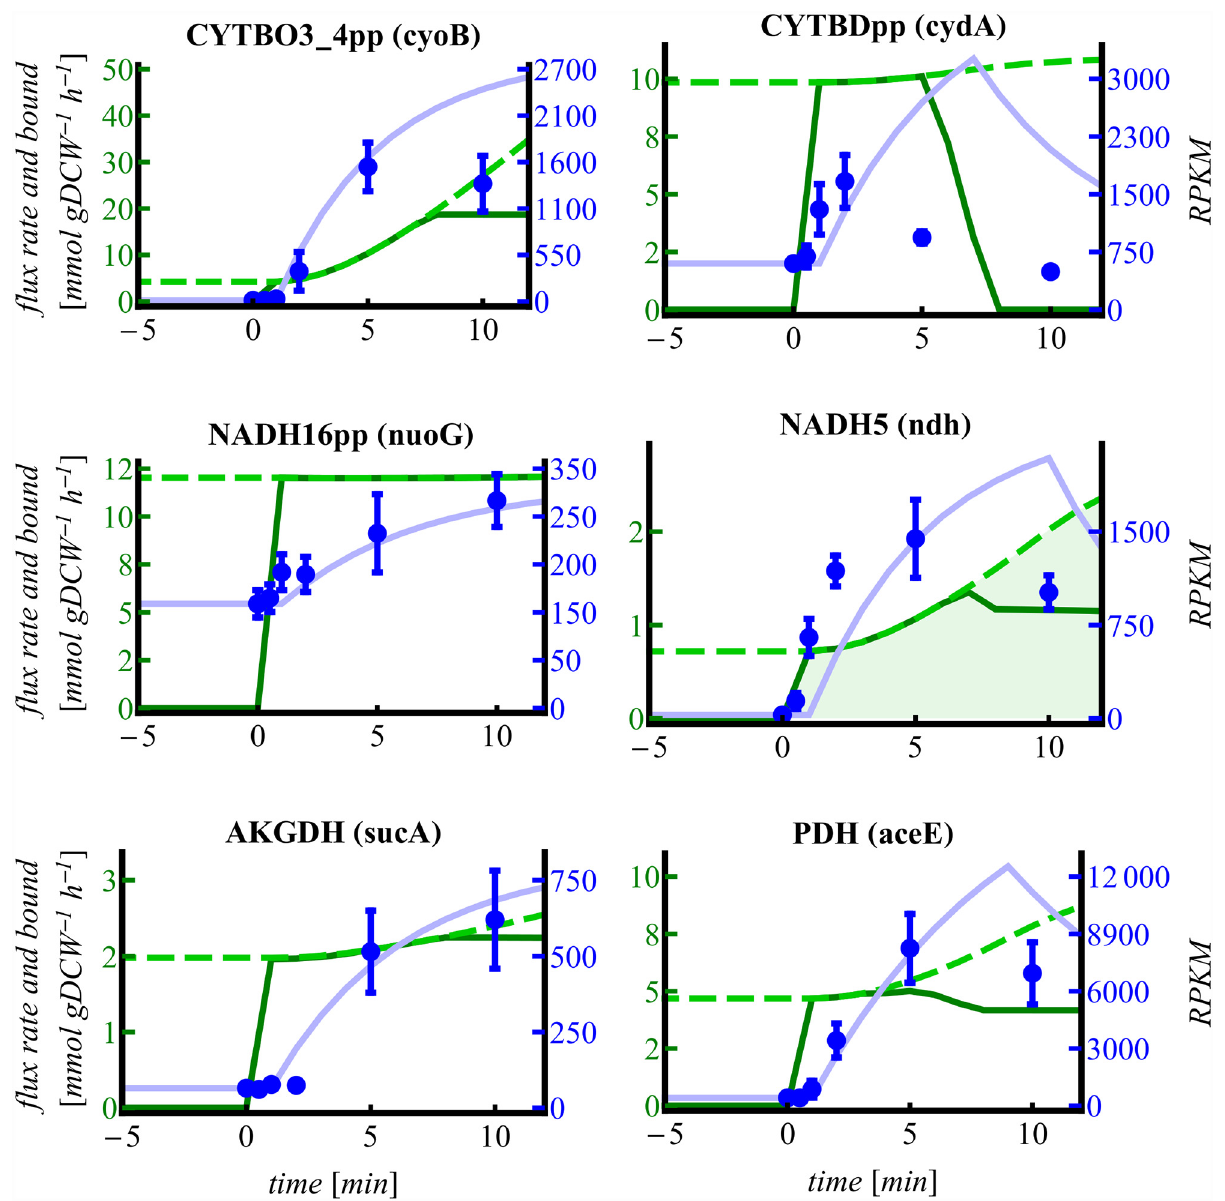
Fig 3. Fluxes of balanced genes in dddFBA. Fluxes are depicted as green lines, upper flux bounds as dashed light green lines, flux variability as shadowed areas and correspond to the left axis; measured mRNA expression as blue dots with standard deviations, and simulated mRNA expression in light blue correspond to the right axis. 0 min denote the onset of